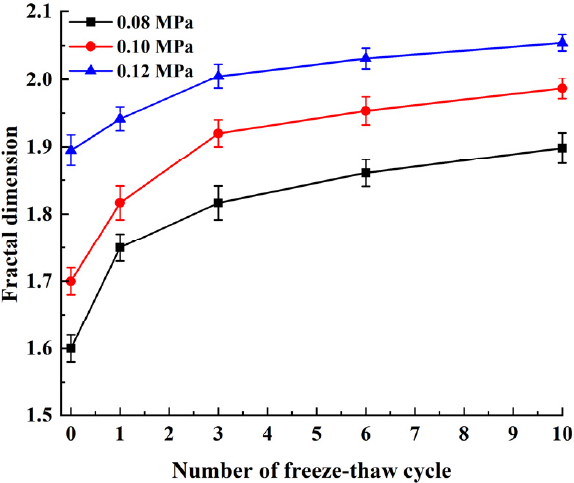
Figure 11. Freeze–thaw cycle number effect on fractal dimension.